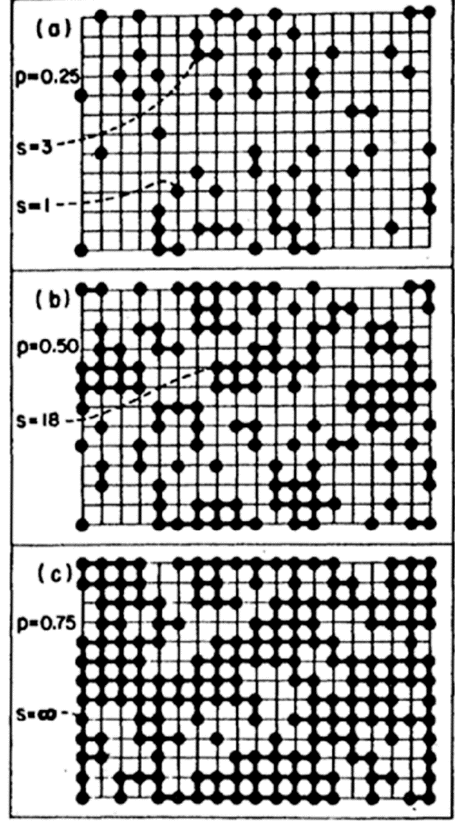
Figure 15. The schematic explanation of site-percolation in a 2D lattice, where the fraction of filled sites (p) are ( a ) 0.25, ( b ) 0.50, and ( c ) 0.75 (gelation point). Reprinted with permission from [4].